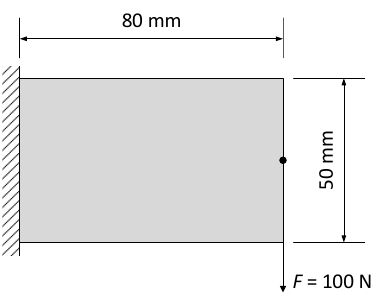
Figure 5. Design domain of a cantilever beam.